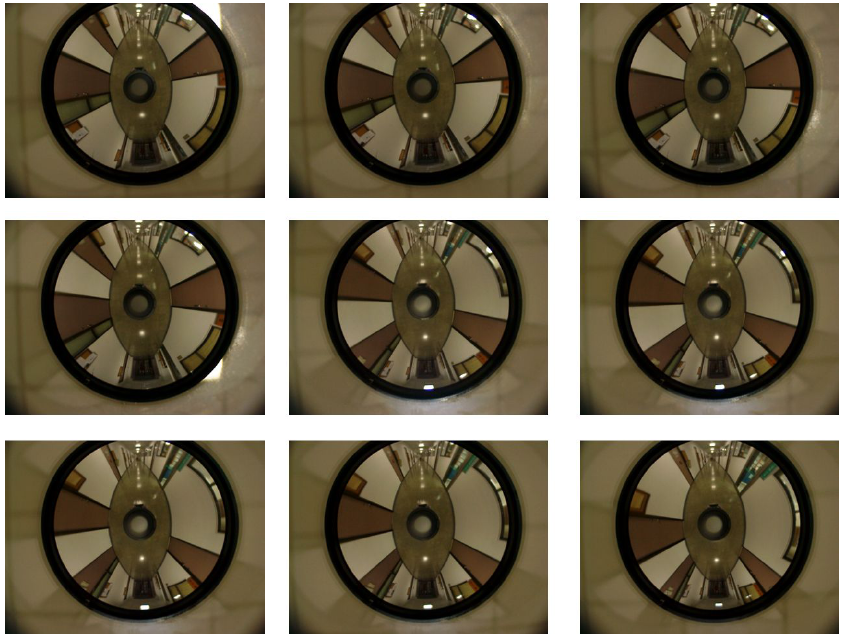
Figure 10. The omnidirectional images used for the self-localization in the first experiment. The mobile robot moved in a straight line when capturing the